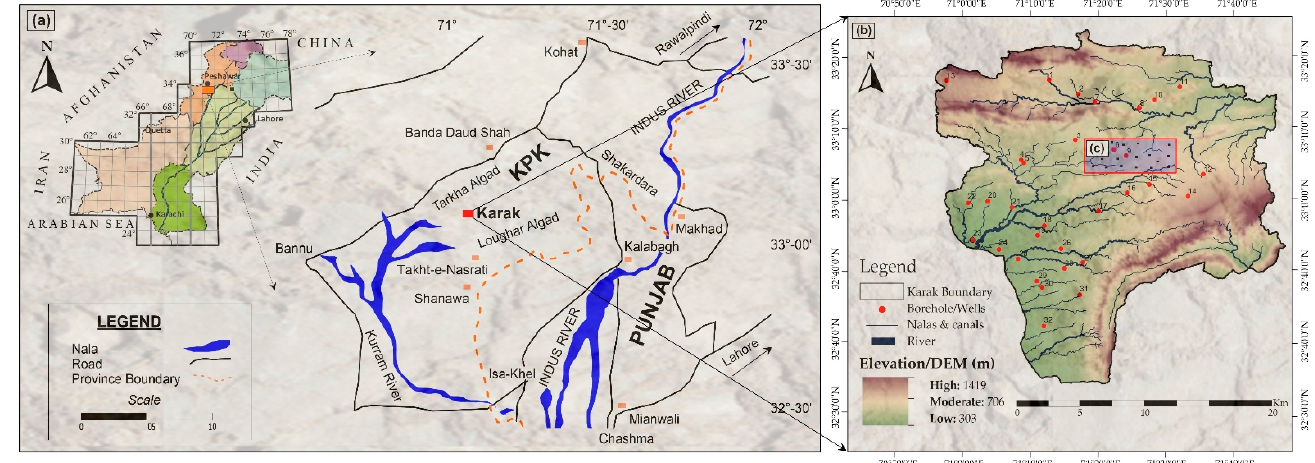
Figure 1. ( a ) Generalized physical geographical features of the Potwar region; and ( b ) Location map of the Karak watershed with the surveyed boreholes and vertical electrical sounding (VES) and electrical resistivity tomography (ERT) measurements.